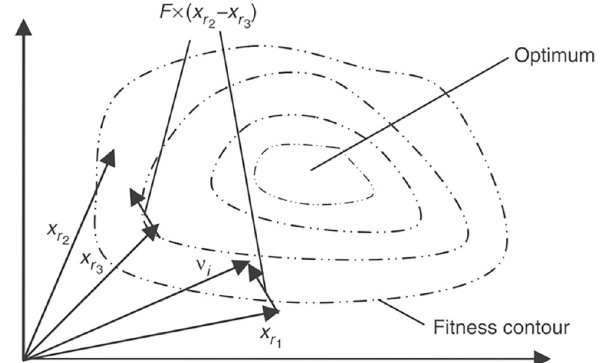
Fig. 2 Mutation process of DE